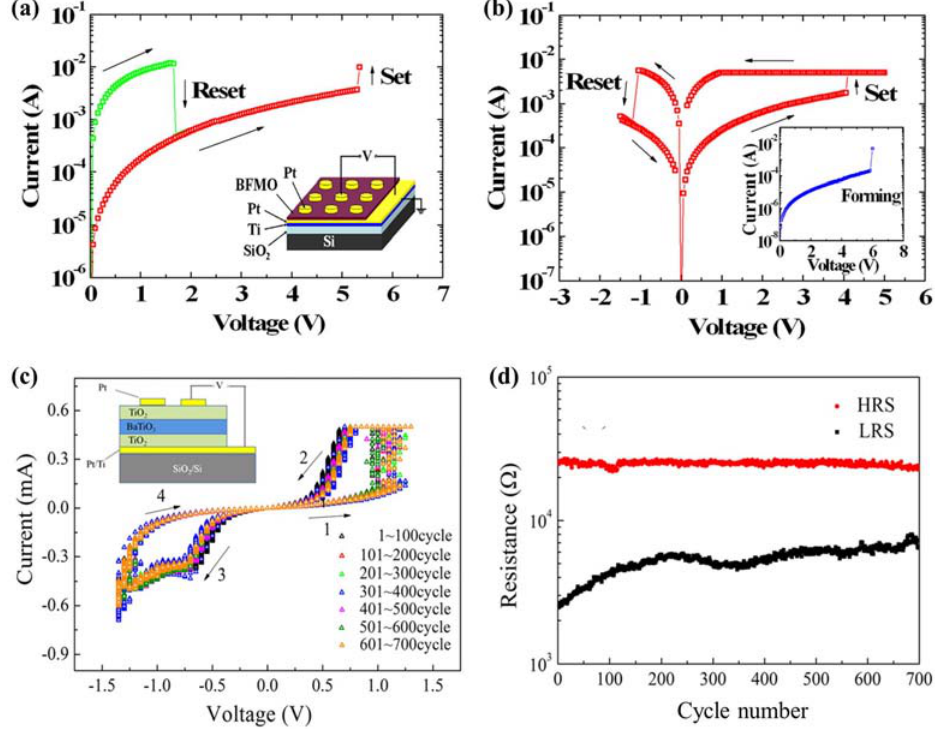
Figure 19. The typical current-voltage behaviors in Pt/BFMO/Pt devices: ( a ) unipolar resistive switching; and ( b ) bipolar resistive switching with absolute values plotted in semi-log scale (Luo et al. [443]). The bipolar resistive switching characteristics in TiO 2 /BaTiO 3 / TiO 2 device: ( c ) I-V curves with 700 consecutive cycles; and ( d ) distributions of V set and V reset in 700 cycles (Ma et al.